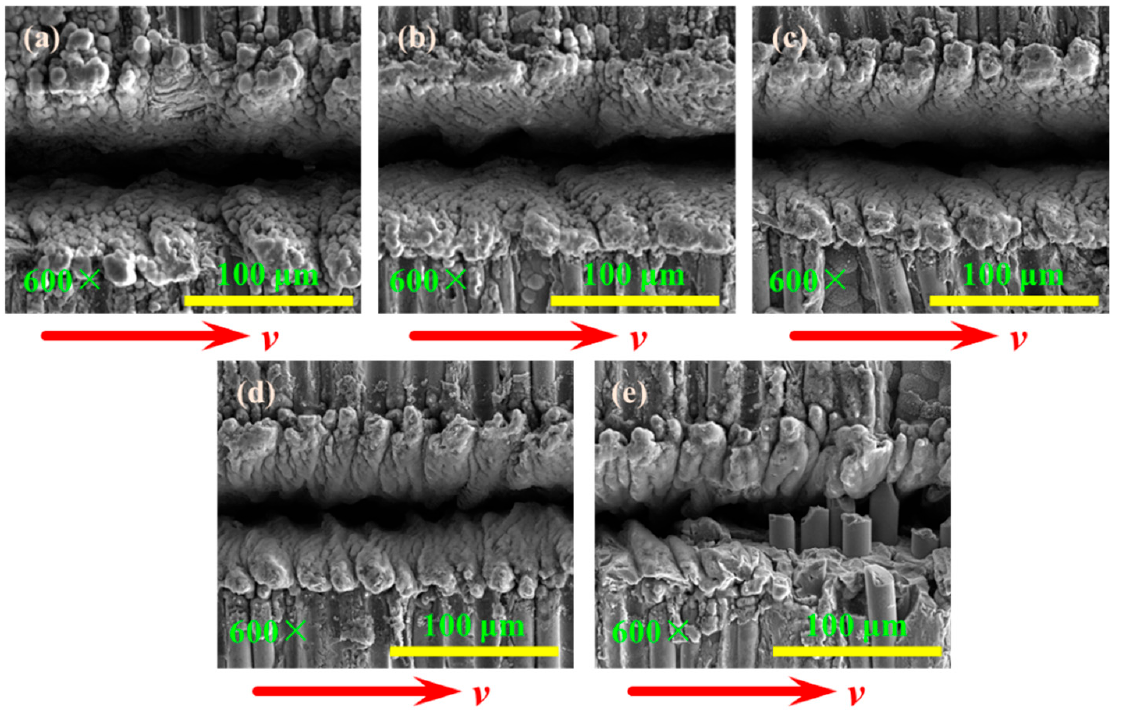
Figure 16. The grooved morphologies corresponding to different repetition frequencies: ( a ) 3 kHz; ( b ) 5 kHz; ( c ) 7 kHz; ( d ) 10 kHz; ( e ) 12 kHz. The fibers are cut by the laser beam from the side of the grooved surface, as shown in Figure 17, when the repetition frequency is 12 kHz, laser power is 10 W, fibers are lon- gitudinal arrangement, and laser beam is transverse scanning ( φ = 19.18 J/cm 2 ). This is because the fiber can be removed when the energy density in the laser spot is small, and the laser beam is directly irradiated on fiber, but the reflected laser cannot remove the fiber. Compared to SiC matrix, SiC fibers are more difficult to be removed by laser.